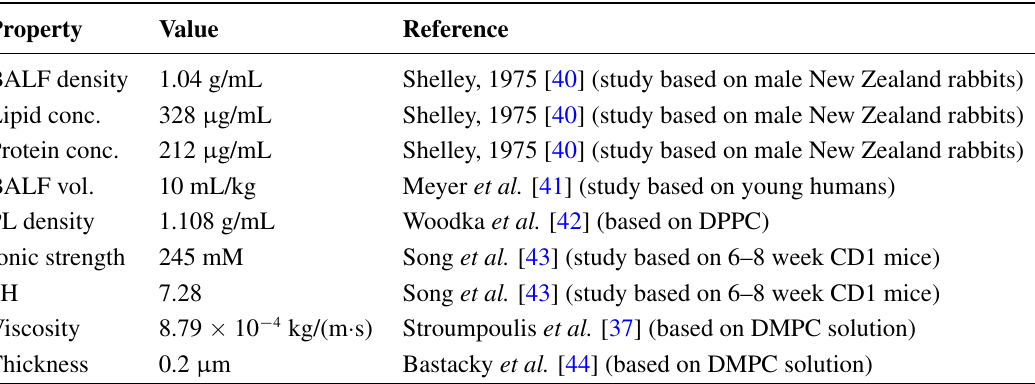
Table 2. Properties of the airway alveolar lining layer. BALF: bronchoalveolar lavage